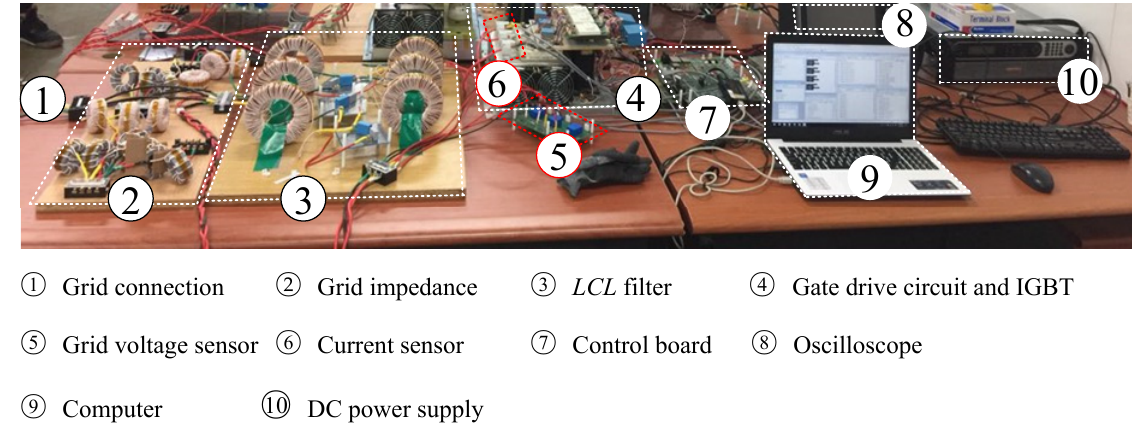
Figure 19. Experimental setup of the three-phase LCL filter type GcI under grid impedance, reprinted with permission from [22] Copyright 2021 Elsevier.